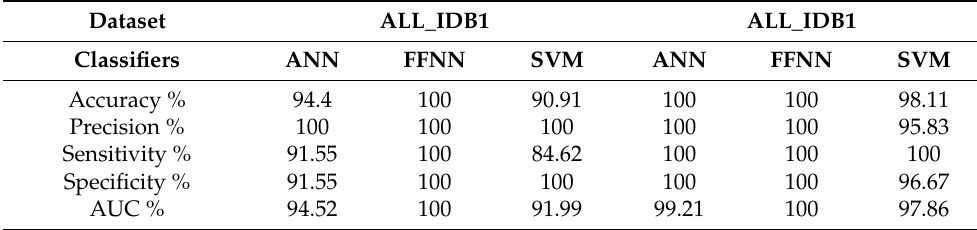
Table 2. The performance of the ANN and FFNN algorithms on the ALL_IDB1 and ALL_IDB2